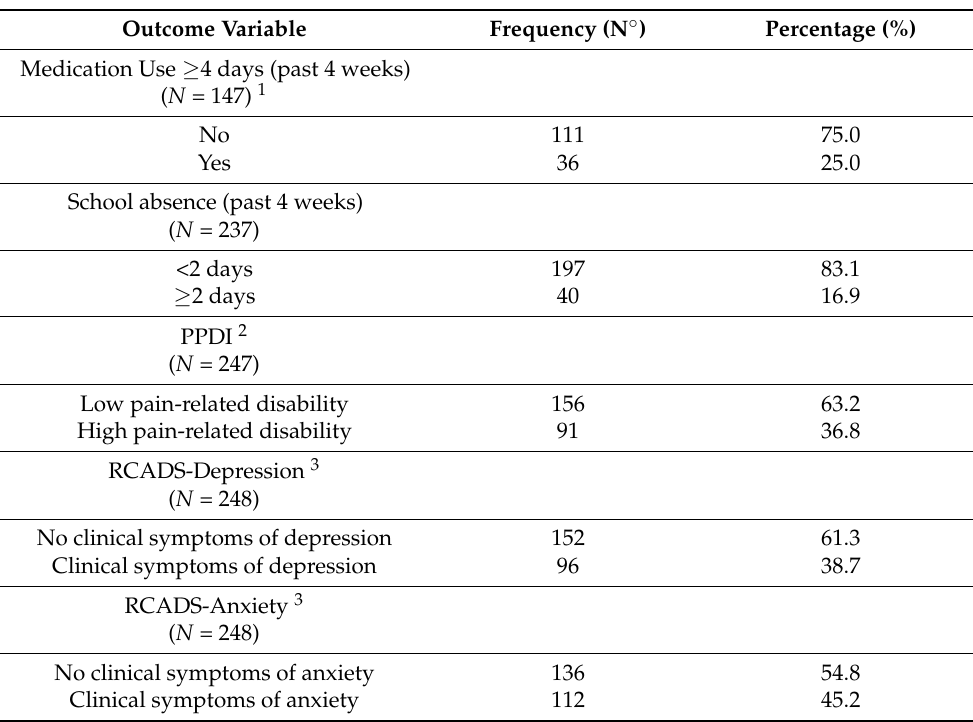
Table 2. Distribution of outcome variable categories for